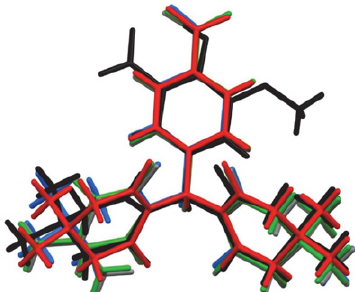
Figure 8. Least-squares overlay of four symmetry-independent molecules of 1 ( a is green, b is blue, c is red and d is gray) and 2